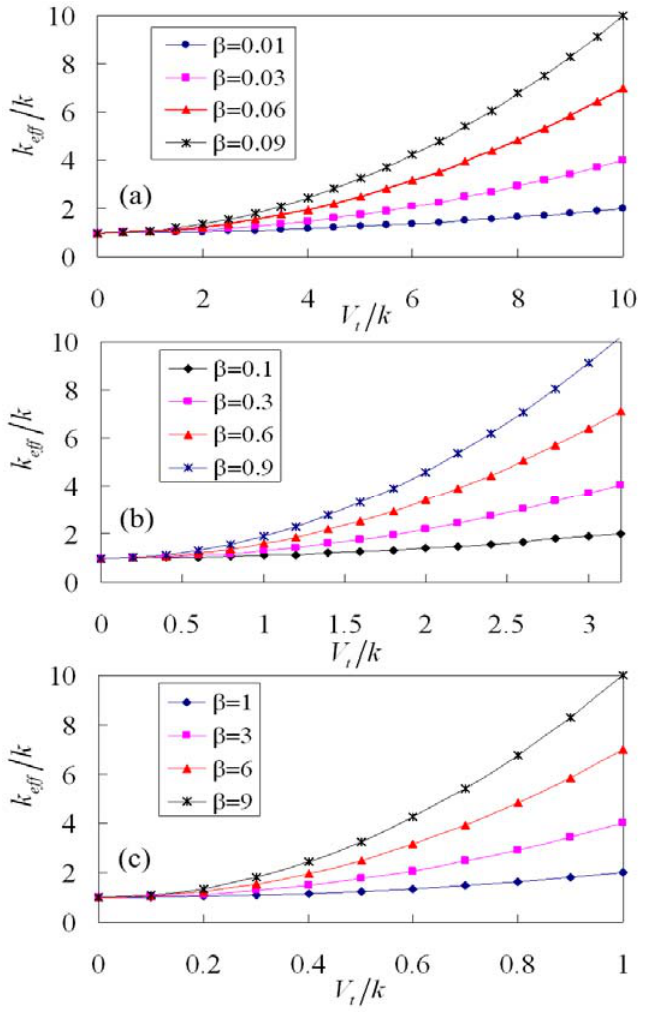
Figure 4. Stiffness ratio of the tunable resonator with different shape